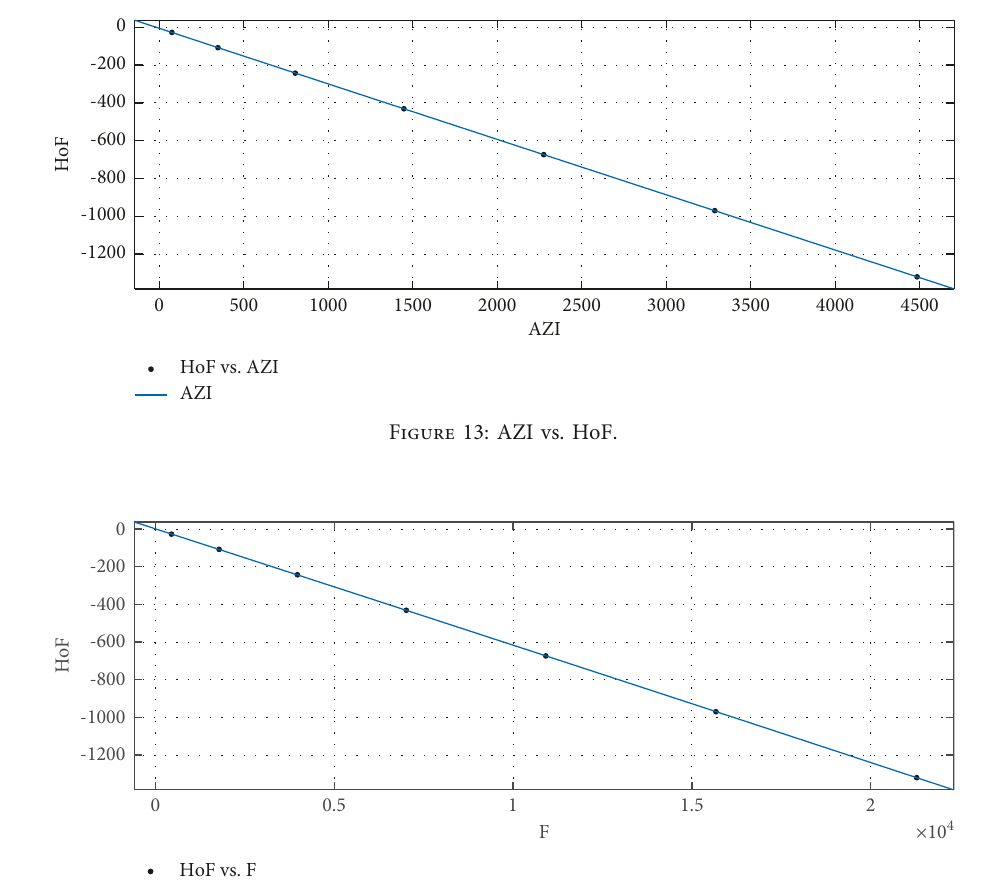
Figure 14: F vs. HoF.